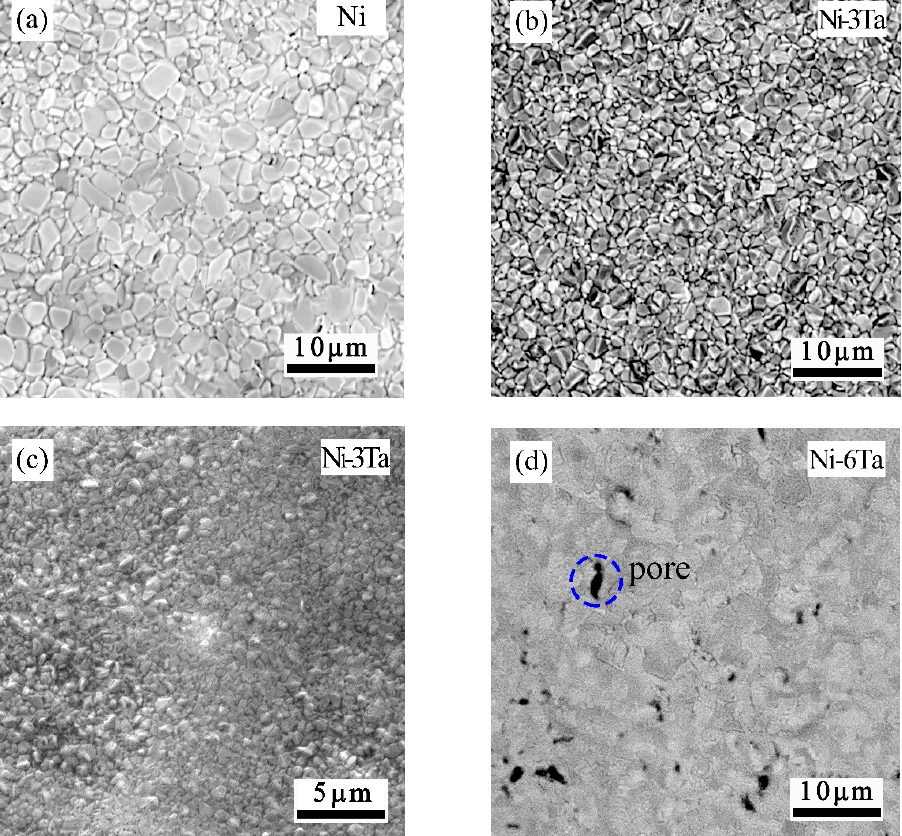
Figure 6. For a better analysis of the oxidation process of Ni-(3~10) Ta and Ni-(3~10) Y alloys. The